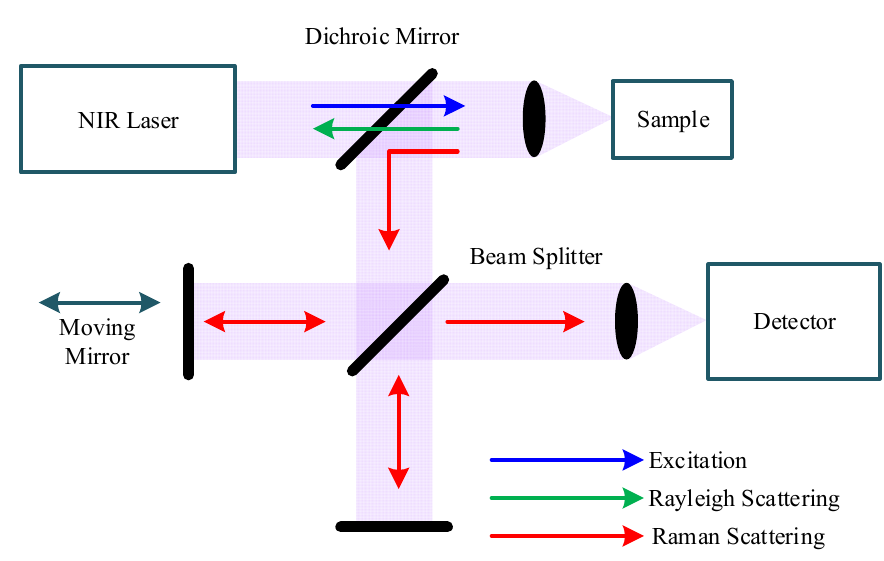
Figure 4. Simplified block diagram of the FT-Raman